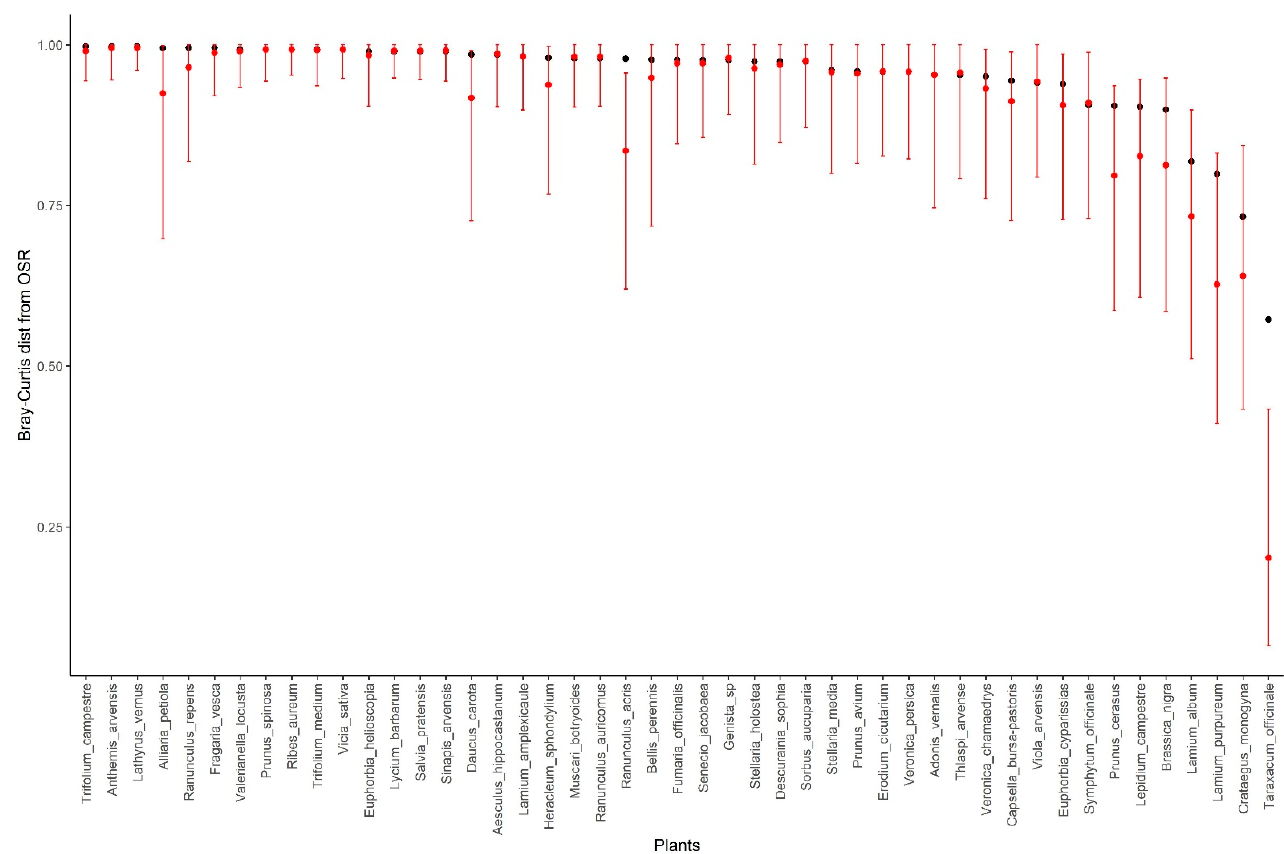
Figure 3. Results of the Bray-Curtis dissimilarity distance of plant species to OSR using a null model. Observed dissimilarity distances are shown in black circles and the mean and 95% confidence intervals of the dissimilarity distances from null models are in red.